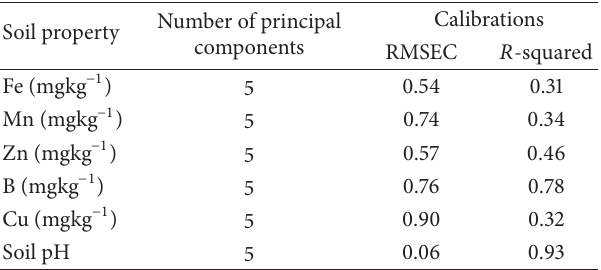
Table 1: Calibration results of soil properties on the southern slopes of Mount Kilimanjaro,